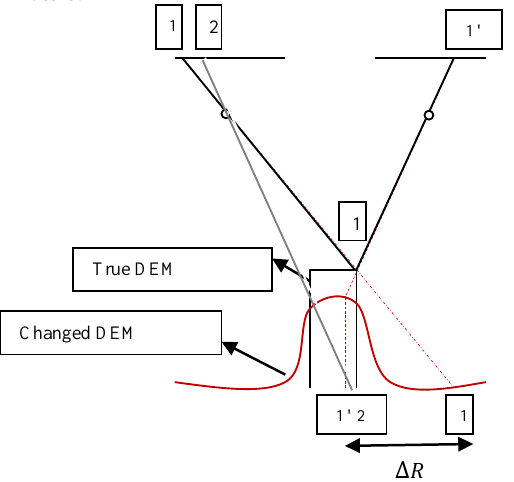
Figure3, The effect of changing DEM on orthophoto mosaic 2.3 visually study of DEM changes on orthophoto